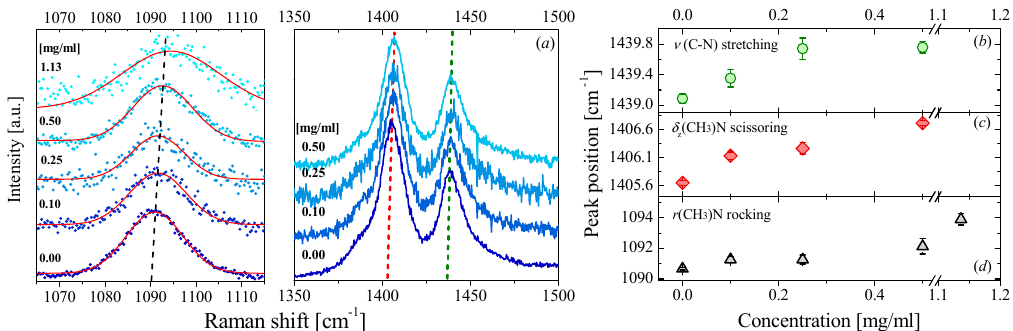
Figure 2. Raman scattering of DMF-based NFs and peak positions of several Raman bands: ( a ) Raman spectra of DMF-based NFs for different graphene concentrations, ( b )–( d ) peak positions of three Raman bands shown in ( a ) as a function of graphene concentration.